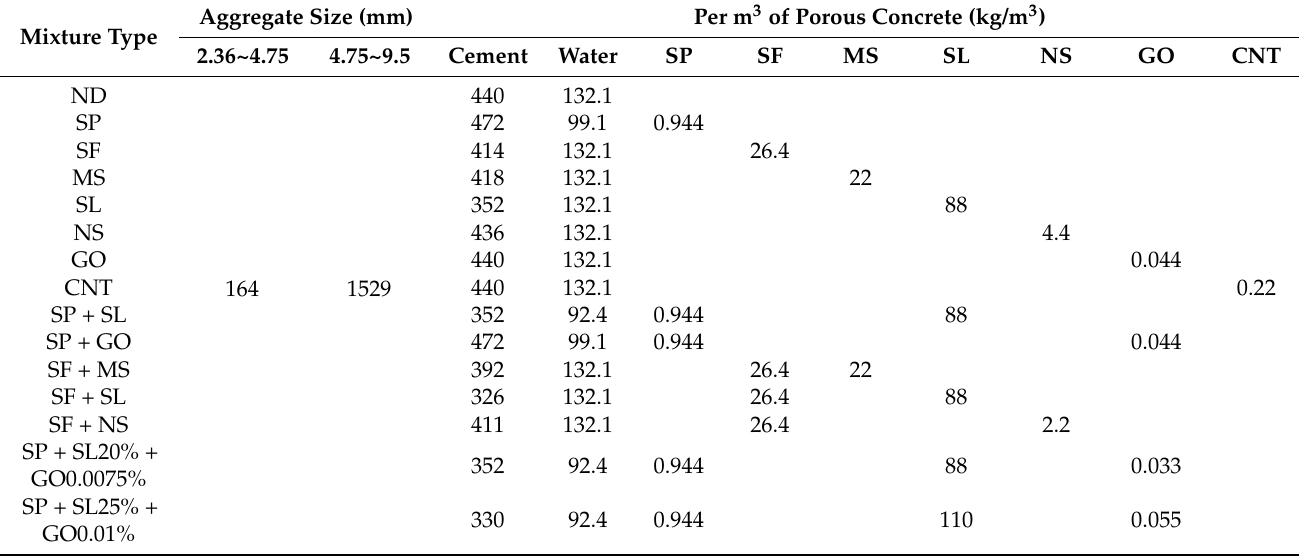
Table 3. Mix proportion of porous concrete.